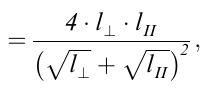
Rock wool board